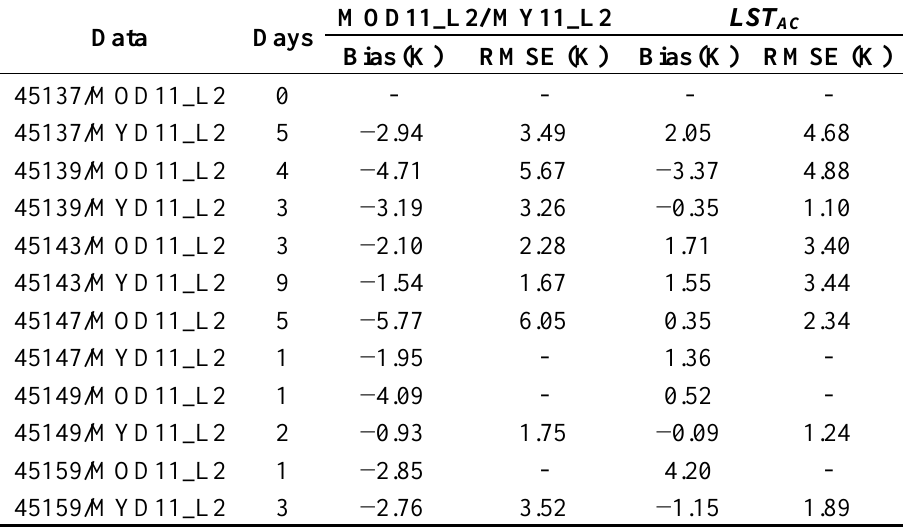
Table 2. Biases and RMSEs of LST errors before and after error correction for buoys 45137, 45139, 45143, 45147, 45149, and 45159. The data are collected from May to November